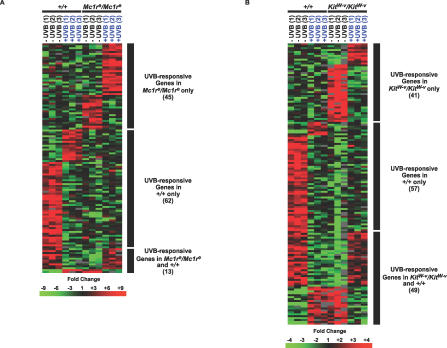
Heatmap of UVB × Pigmentation Genotype Interaction Genes in the Basal Epidermis of P2.5 MiceTwo-way ANOVA tests, using 13,508 genes, were performed on Mc1r+/Mc1r+ and Mc1re/Mc1re samples (−UVB and +UVB) and Kit+/Kit+ and KitW-v/KitW-v (−UVB and +UVB) samples, yielding 120 Mc1r-dependent and 147 Kit-dependent UVB interacting genes. Post hoc analyses, using pairwise Student's t-tests, were used to reveal interactions between specific genotypes and UVB treatment. The ordered columns of the heatmap represent replicates of sham- (black) and UVB-irradiated (blue) basal epidermal samples derived from +/+, Mc1re/Mc1re, and KitW-v/KitW-v P2.5 mice. The genes are represented by rows and are arranged to illustrate interactions in the basal epidermis between UVB and Mc1r (A) and UVB and Kit (B). Red, green, and black indicate induction, repression, and no change, respectively, relative to the centered median. Gray represents missing data. The ratio fold-change is indicated by a scale bar.